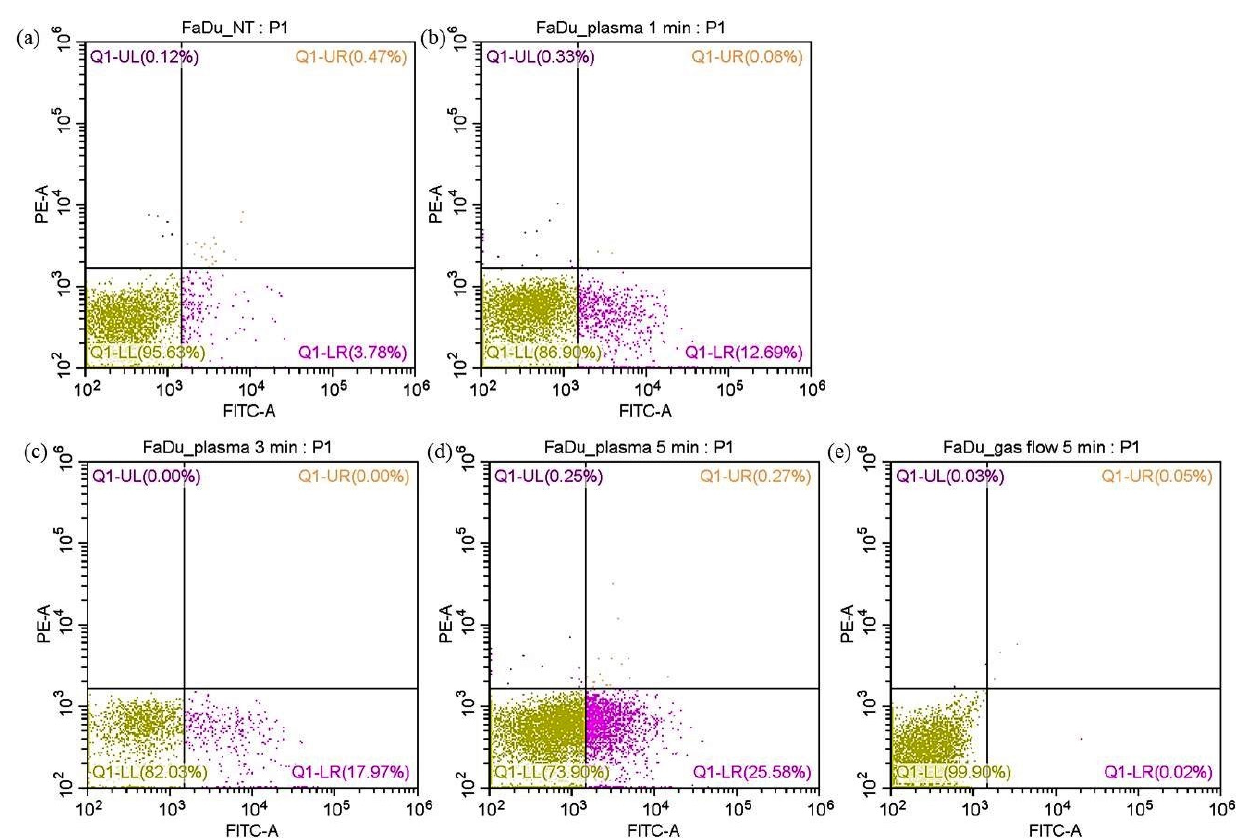
Figure 6. FaDu response under ( a ) NT ( b ) 1, ( c ) 3, and ( d ) 5 min of He plasma and ( e ) 5 min of He gas flow exposure after 24 h. The cells were stained by Annexin V/PI and the cell response was quantified using flow cytometry (event counts = 10,000).